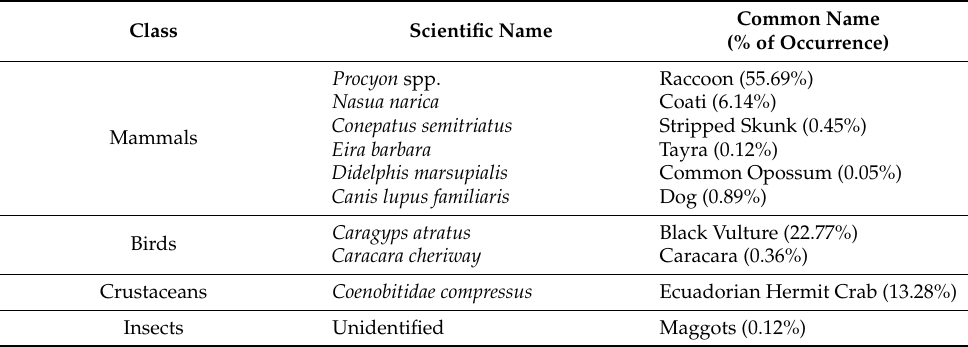
Table 2. Olive Ridley sea turtle egg predators and scavengers identified at Corozalito during the sampling